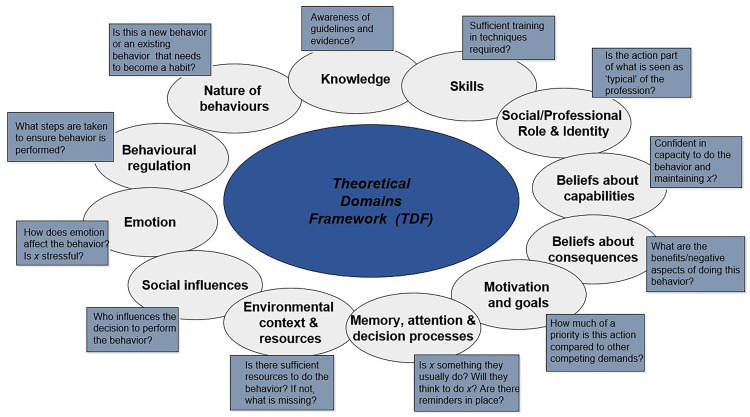
Theoretical domains framework [19].